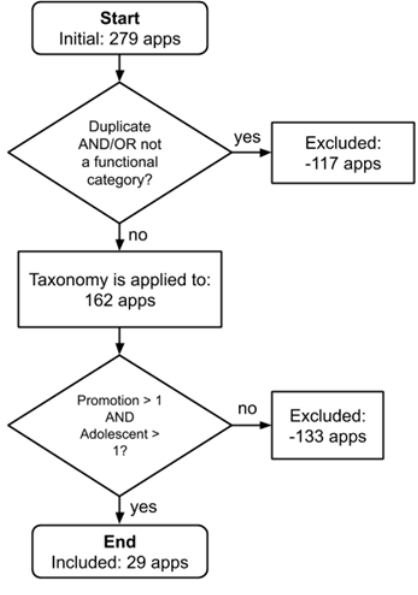
Figure 1. Selection